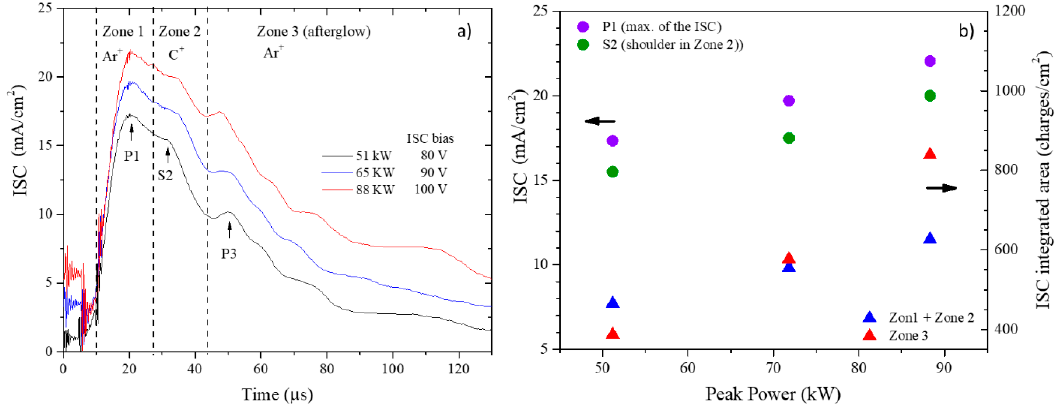
Figure 3. Ion saturation current ( a ), and area and maximum values of the ion saturation current (ISC) ( b ) as a function of the peak power. According to the above discussion, the time-resolved ISCs can be divided into three different temporal zones, as shown in Figure 3a. Zone 1, which corresponds to plasma ignition, is dominated